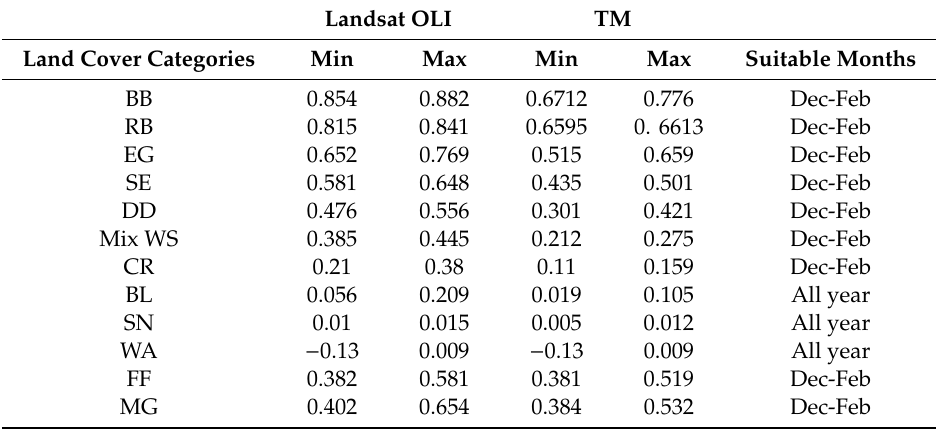
Table A2. Land cover categories mid-dry phenology season median threshold values of TM (2000–2003) and OLI (2014–2017)